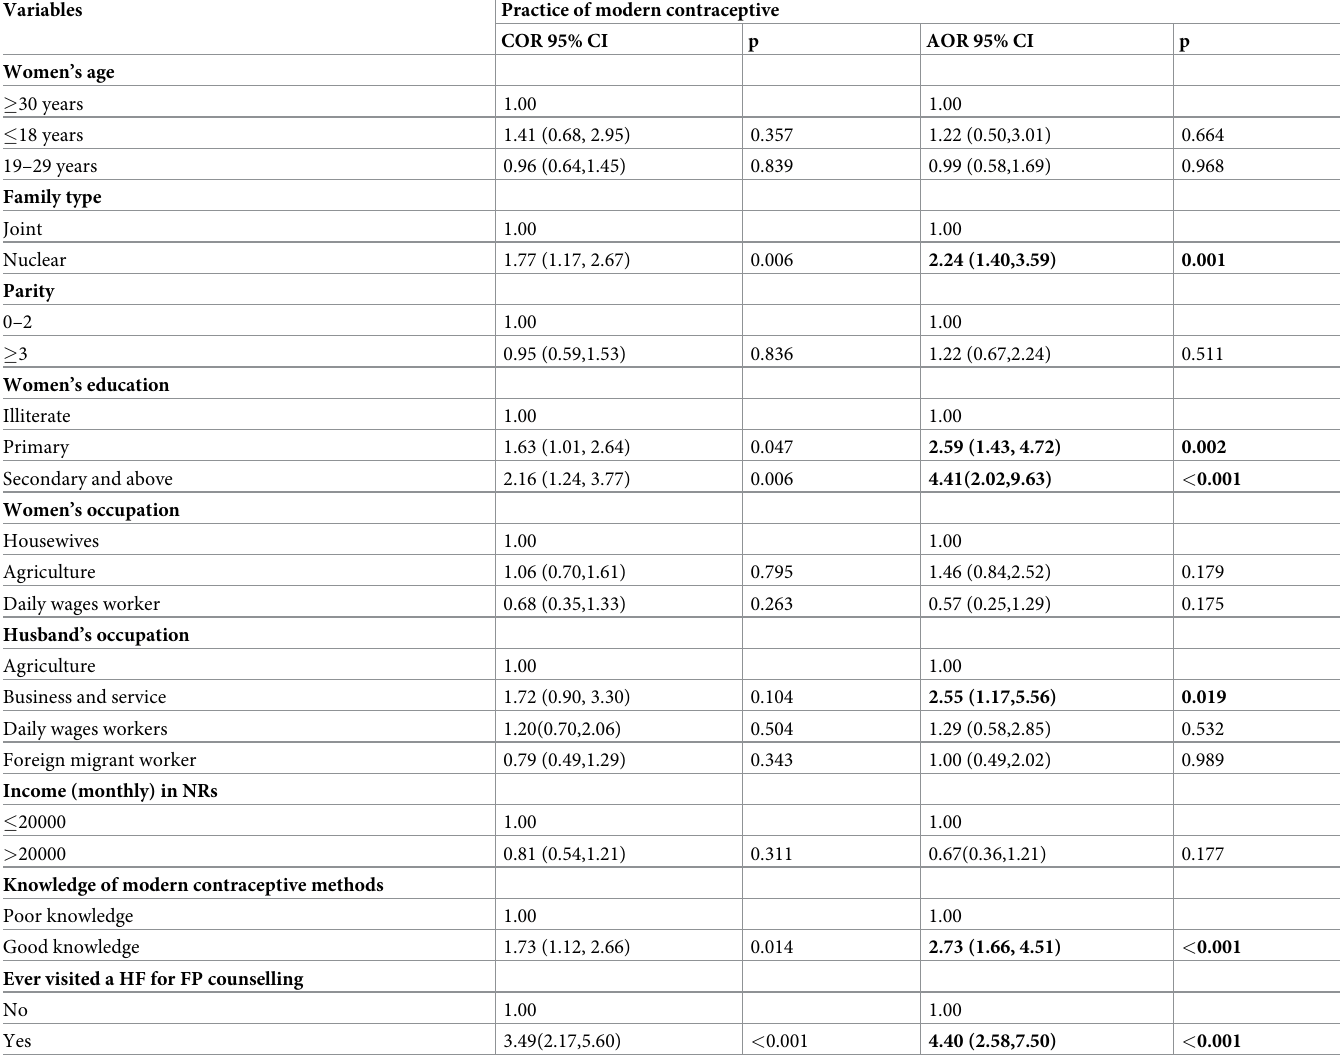
Table 5. Determinants of good practices of modern contraceptive methods among Nepali Muslim women (N =